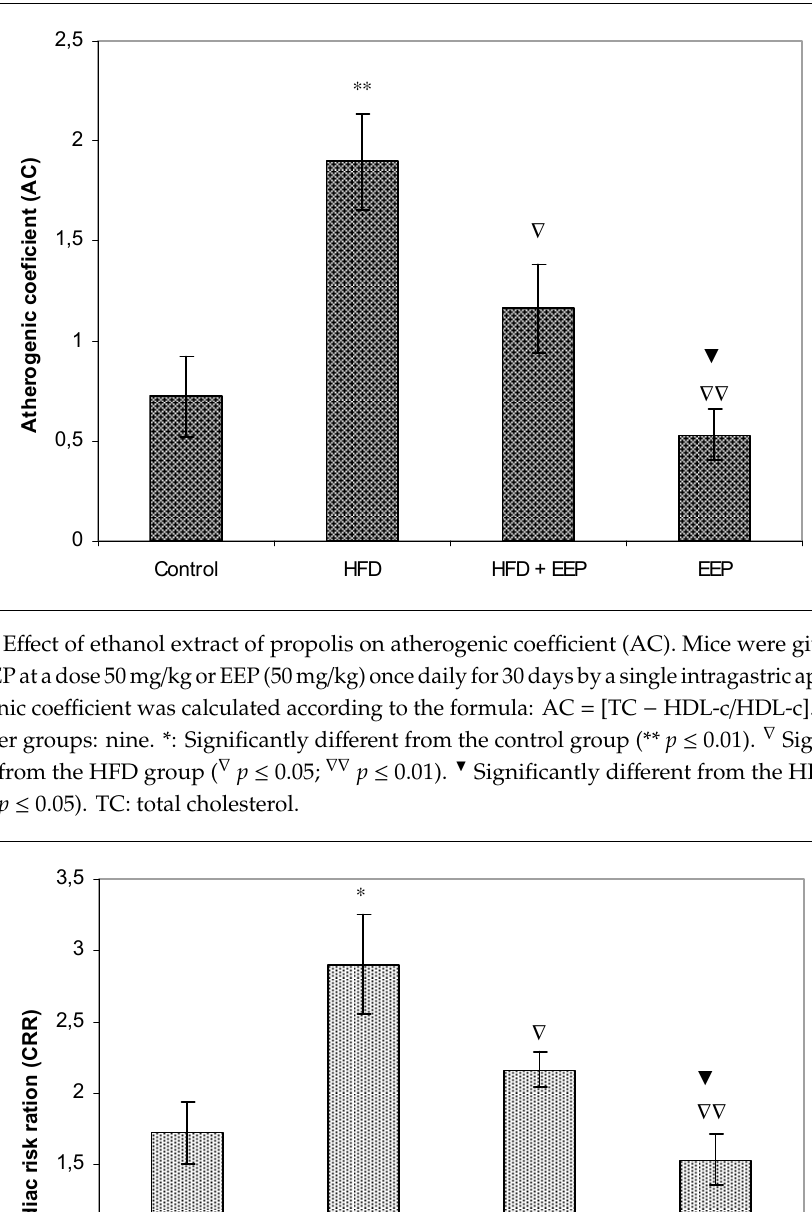
HFD, HFD + EEP at a dose 50 mg/kg or EEP (50 mg/kg) once daily for 30 days by a single intragastric